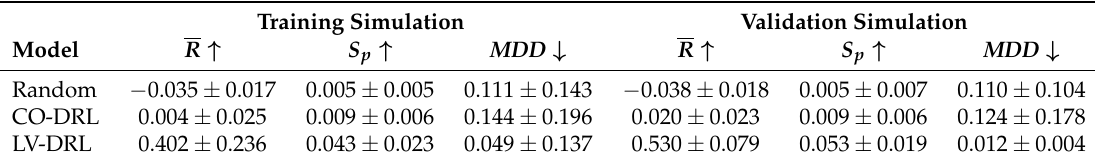
Table 1. Model performances of random, CO-DRL, and LV-DRL models. R , S p , and MDD are average reward, Sharpe ratio, and maximum drawdown. Indices in the table are mean and standard deviation of sub